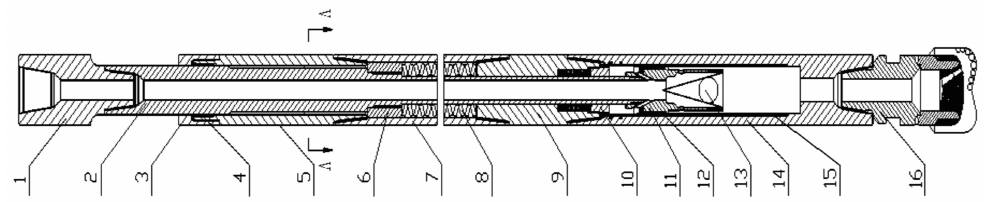
Figure 1. Schematic diagram of the structure of the speed-up device by drill string’s absorption and hydraulic supercharging. Tool upper joint: 1. The spindle; 2. Upper seal assembly gland; 3. Upper seal assembly; 4. The external spline; 5. The limit body; 6. Protection tube; 7. Spring; 8. Joint in tool; 9. Lower seal assembly; 10. Plunger head; 11. Sliding seal assembly; 12. Control check valve; 13. Plunger cylinder outer cylinder; 14. Plunger liner; 15. Pressurization chamber; 16. Drill bit.